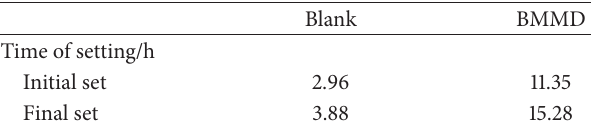
Table 5: Setting